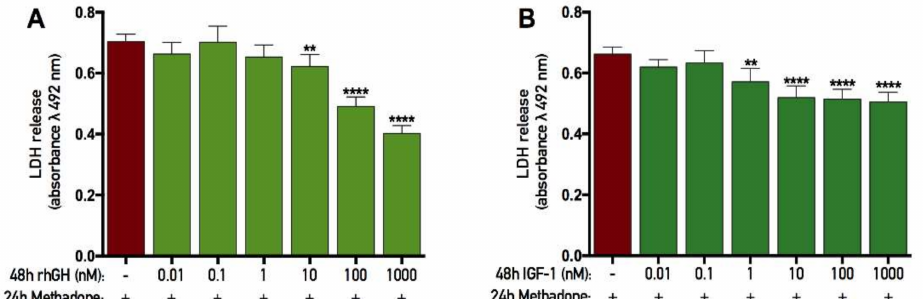
Figure 7. Recovery effects of recombinant human growth hormone and insulin-like growth factor-1 on membrane integrity following methadone-induced toxicity. Membrane integrity was assessed by lactate dehydrogenase (LDH) assay. Methadone (60 µ M) was added for 24 h and then washed out. The following 48 h, recombinant human growth hormone (rhGH) and insulin-like growth factor-1 (IGF-1) were added for two consecutive days prior to analysis. ( A ) The 48 h recovery effect of rhGH in cells with methadone-induced membrane damage. A significant reduction in LDH release during the recovery phase was observed using 10, 100, and 1000 nM rhGH. ( B ) The 48 h recovery effect of IGF-1 in cells with methadone-induced membrane damage. A significant reduction in LDH release during the recovery phase was observed using 1, 10, 100, and 1000 nM IGF-1. Statistics were calculated using two-way analysis of variance (ANOVA) and given a significant overall effect ( p < 0.05), the data were further analyzed using Dunnet’s post hoc test compared to cells exposed to control during the 48 h recovery phase. All data are presented as mean ± SEM in triplicate from five individual cultures. ** p < 0.01, **** p <